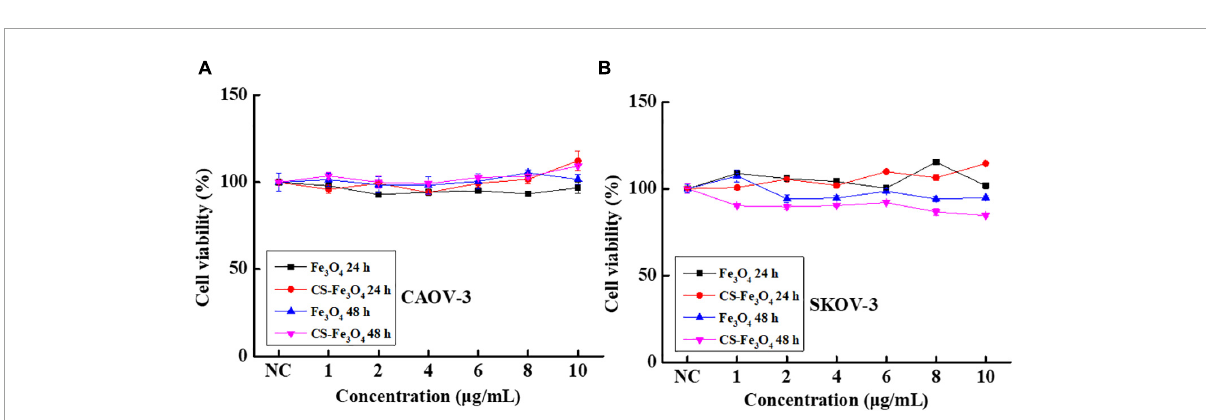
FIGURE5 Cell viability of (A) CAOV-3 cells and (B) SKOV-3 cells with Fe 3 O 4 and CS-Fe 3 O 4 nanoparticles under different concentrations and treatment periods.